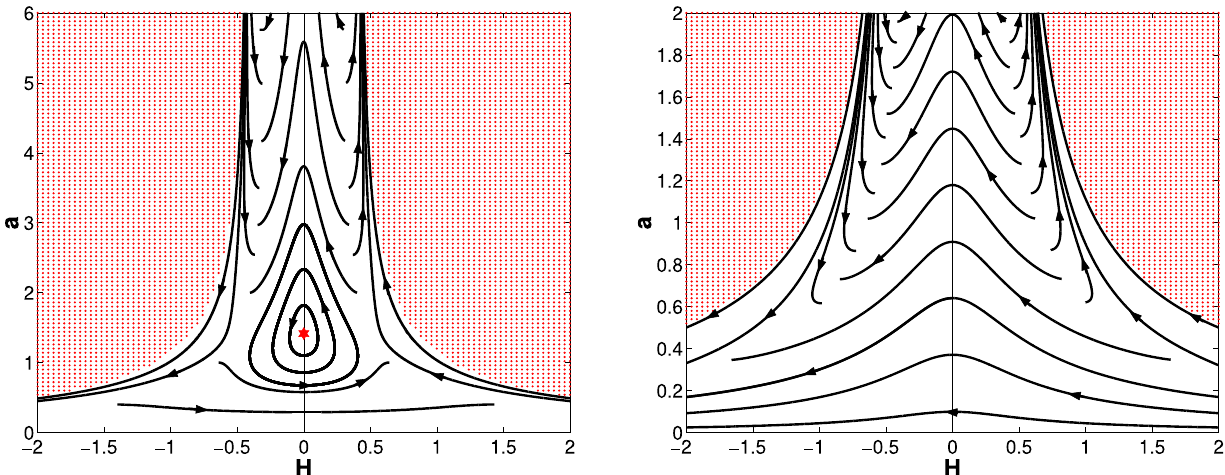
Fig. 1 The phase portraits are plotted for N = 2, f 0 = 1 dotted regions correspond to ρ < 0 in the constraint equation (11)